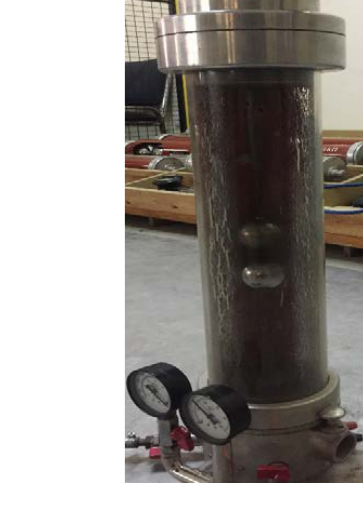
Figure 2. Test equipment used: ( a ) experimental setup; ( b ) testing vessel (HV-9134);